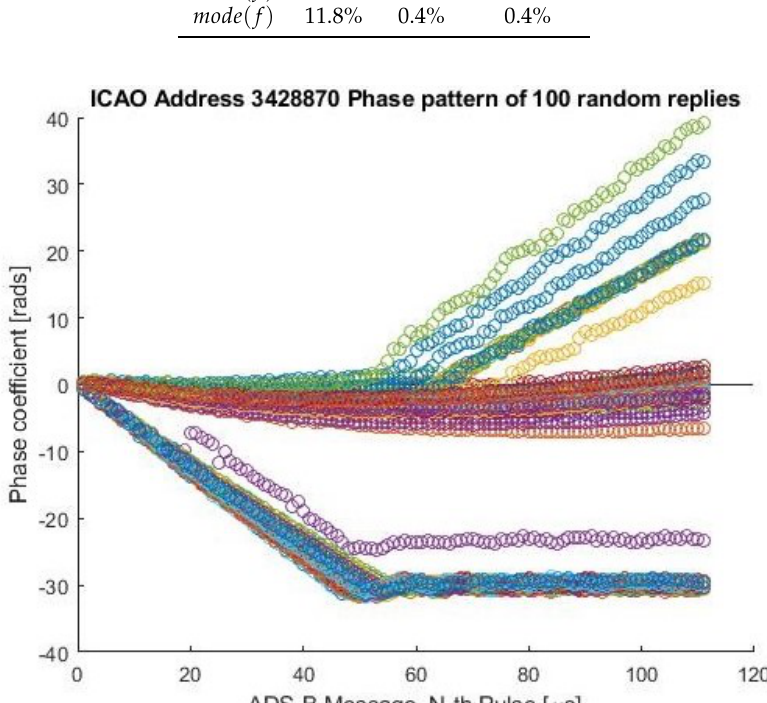
Figure 3. Example of Nonstationary Transponder. Phase patterns of consecutive messages of the same transponder. Different colors represent different message phase patterns of the same